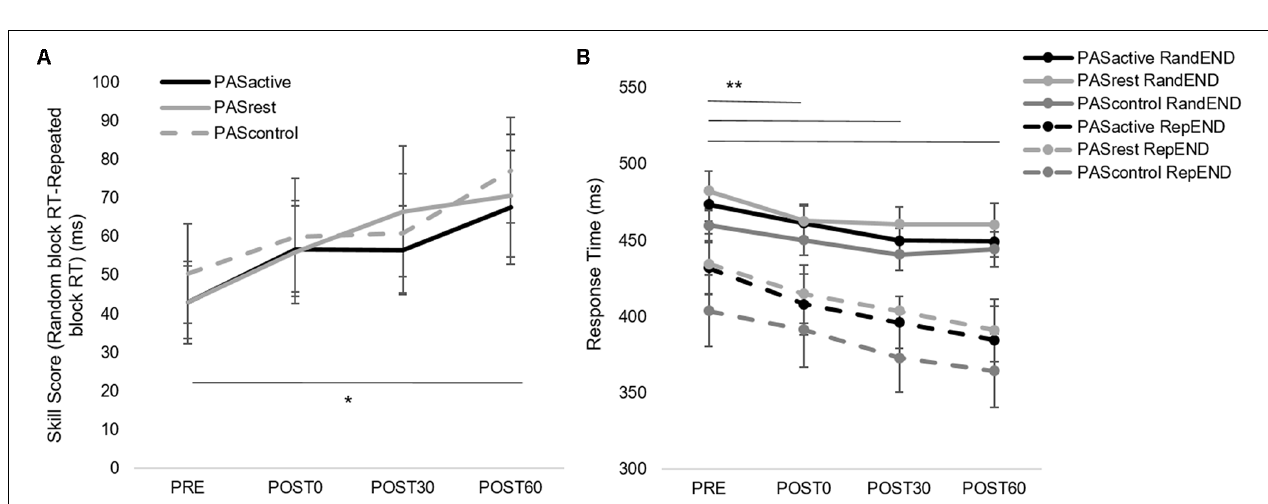
FIGURE 5 | (A) Skill score and (B) random block RT during SRTT assessment (mean ± SE) for PAS ACTIVE , PAS REST ,and PAS CONTROL conditions for each within-session time points. Skill score improved over time ( ∗ p = 0.03) and RT decreased ( ∗∗ p < 0.001) in both conditions.